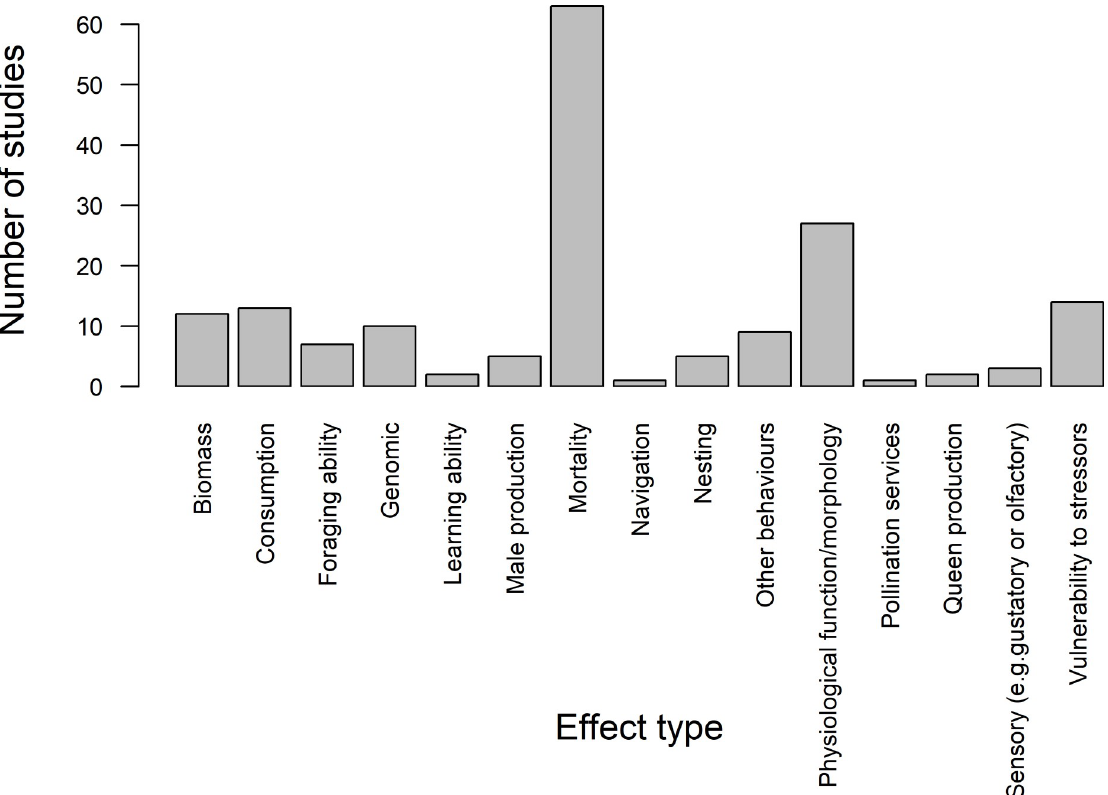
Fig 4. The number of studies found that tested the impacts of fungicides and/or herbicides on each effect